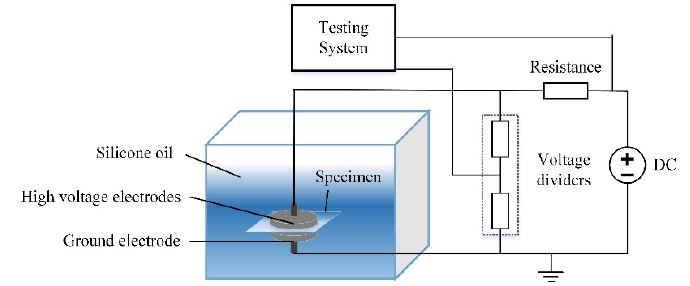
Figure 2. Schematic diagram of the breakdown device.